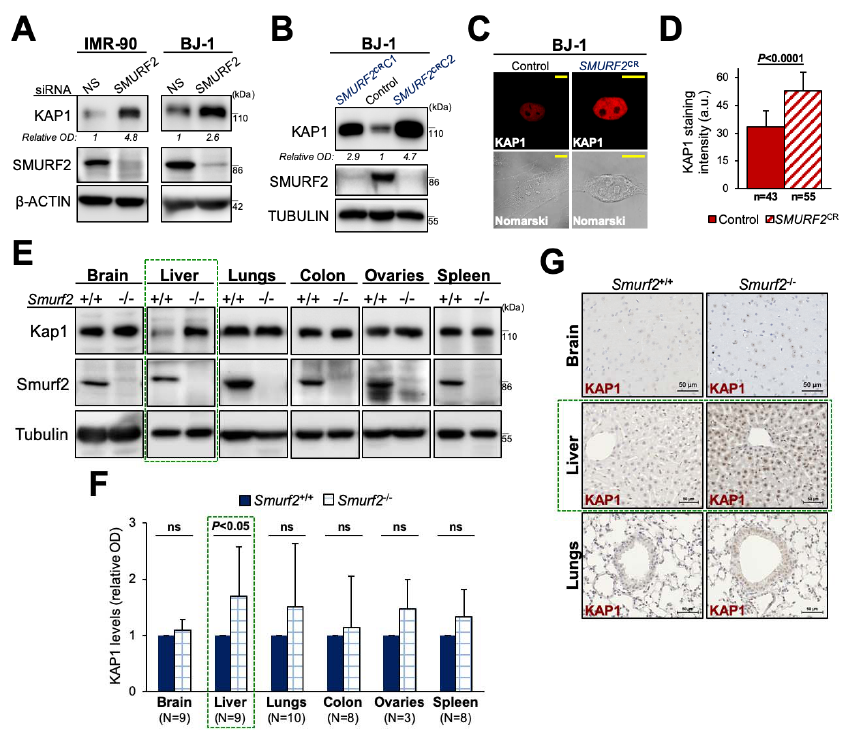
Figure 4. SMURF2 exerts a negative impact on KAP1 expression in untransformed human cells and normal mouse tissues. ( A ) Western blot analyses of KAP1 expression in IMR ‐ 90 and BJ ‐ 1 cells knocked down of SMURF2. NS—non ‐ silencing siRNA. ( B ) Immunoblot analysis of KAP1 expression in SMURF2 knock ‐ out ( SMURF2 CR ) BJ1 cells. Two different SMURF2 CRISPR clones ( SMURF2 CR C1 and SMURF2 CR C2) were examined. ( C , D ) Confocal microscopy analysis of KAP1 protein expression in SMURF2 CR BJ1 cells. Scale bars: 10 μ m. Quantification of the results (panel D) is presented as mean ±S D. n—number of cells quantified for each group from at least 10 different fields. ( E ) Western blot analysis of KAP1 expression in Smurf2 KO ( Smurf2 − / − ) and littermate control wild ‐ type ( Smurf2 +/+ ) mouse tissues. ( F ) Quantification of data shown in ( E ) obtained in different pairs of mice. Data are mean ± SD. N—number of animals. ( G ) IHC staining of KAP1 (brown) in Smurf2 WT and KO mouse tissues. The nuclei were counterstained with hematoxylin (blue). Scale bars: 50 μ m. The uncropped Western blot images can be found in Figure S6.